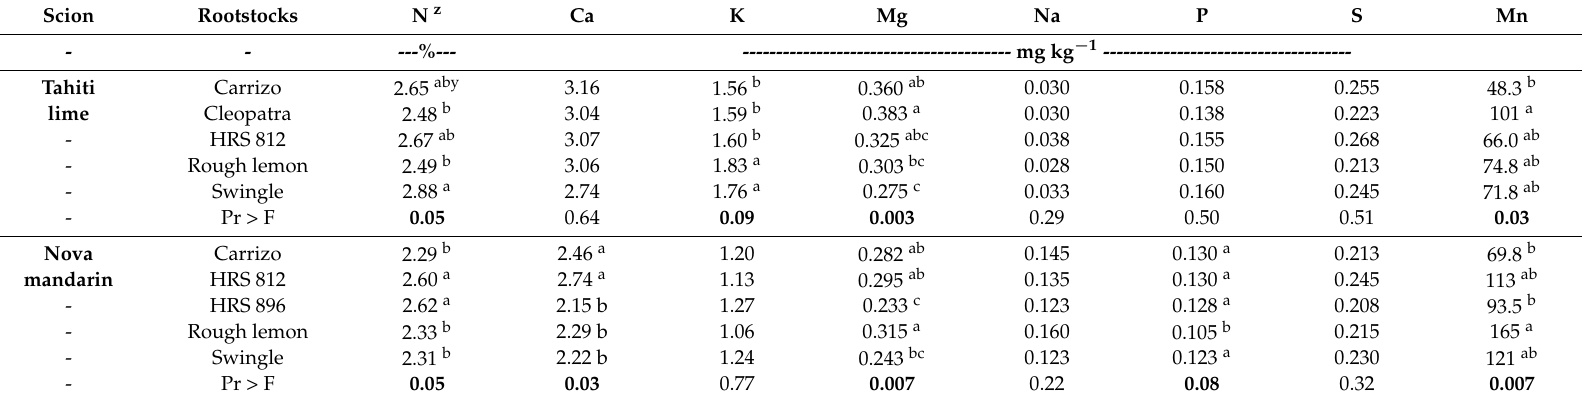
Table 2. Mean concentrations of plant nutrients in two citrus orchards grown in Coto series grafted to five different rootstocks planted at the Agricultural Experiment Substation of Isabela, Puerto